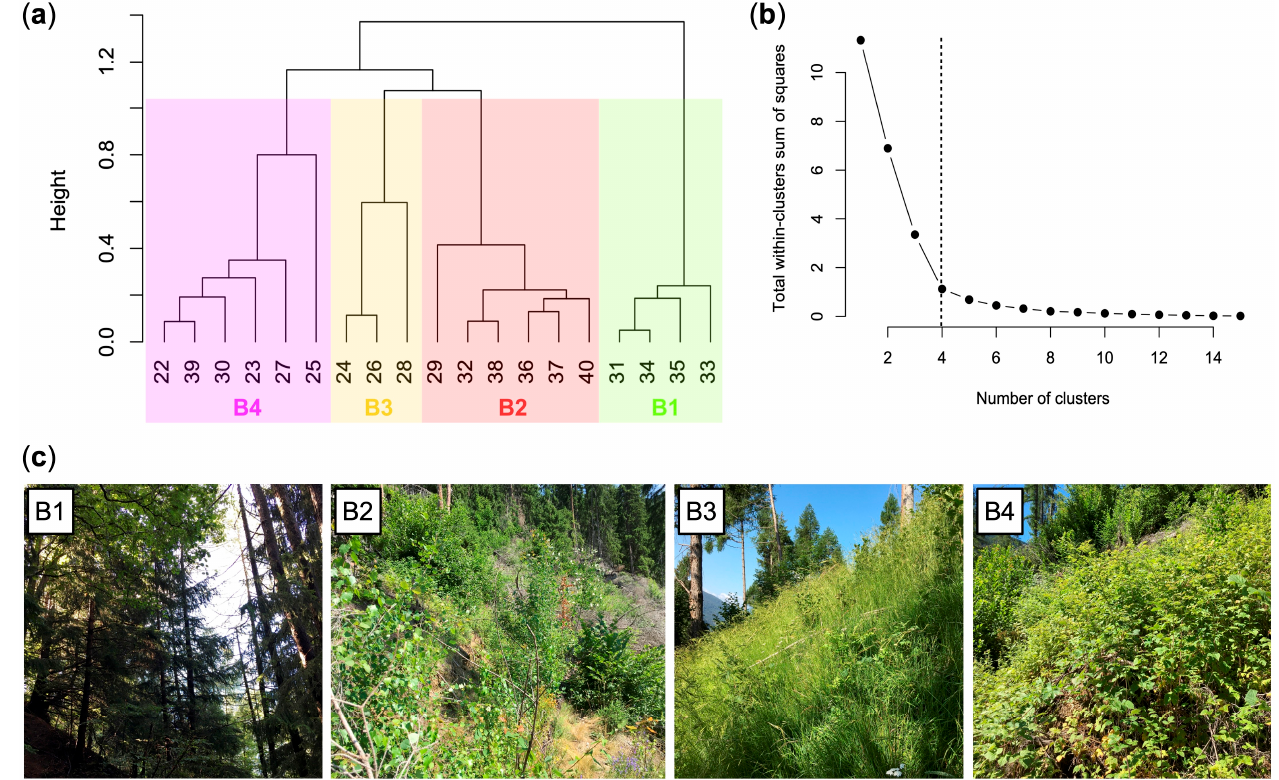
Figure 6. Dendrogram of the relev é s of study area B ( a ), distribution of total within-clusters sum of squares by number of relev é groups distinguished via hierarchical clustering ( b ), and photographs of the four vegetation types ( c ). Key: B1, Picea abies forest; B2, Astrantio-Corylion avellanae ; B3, Brachypodium rupestre-Astragalus glycyphyllos community; B4, Rubetum idaei